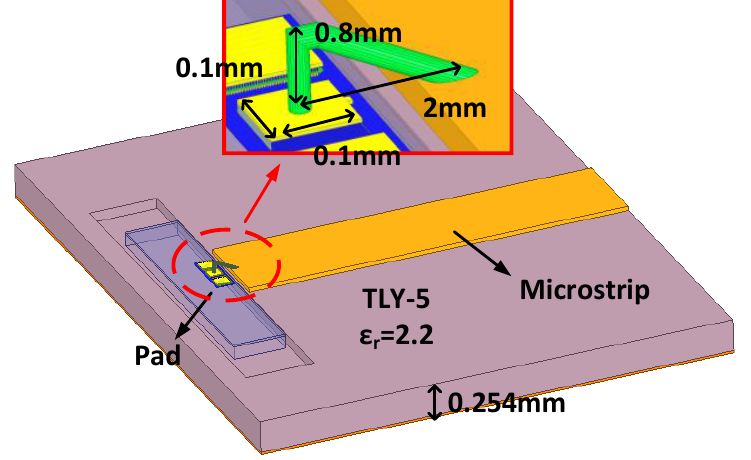
Figure 8. 3D model of the RF GSG PAD to microstrip transition. Figure 10 shows the S-parameters of the transition structure between the simulated RF GSG PAD and the microstrip line and the microstrip line to the WR12 waveguide port in the entire E-band. As illustrated in Figure 10, in the channel emulator operating frequency band 66–67 GHz, the return losses (S11, S22) of the above connection structures are all better than − 10 dB, and the total insertion loss between the RF GSG PAD and the WR12 waveguide port is equal to less than 2